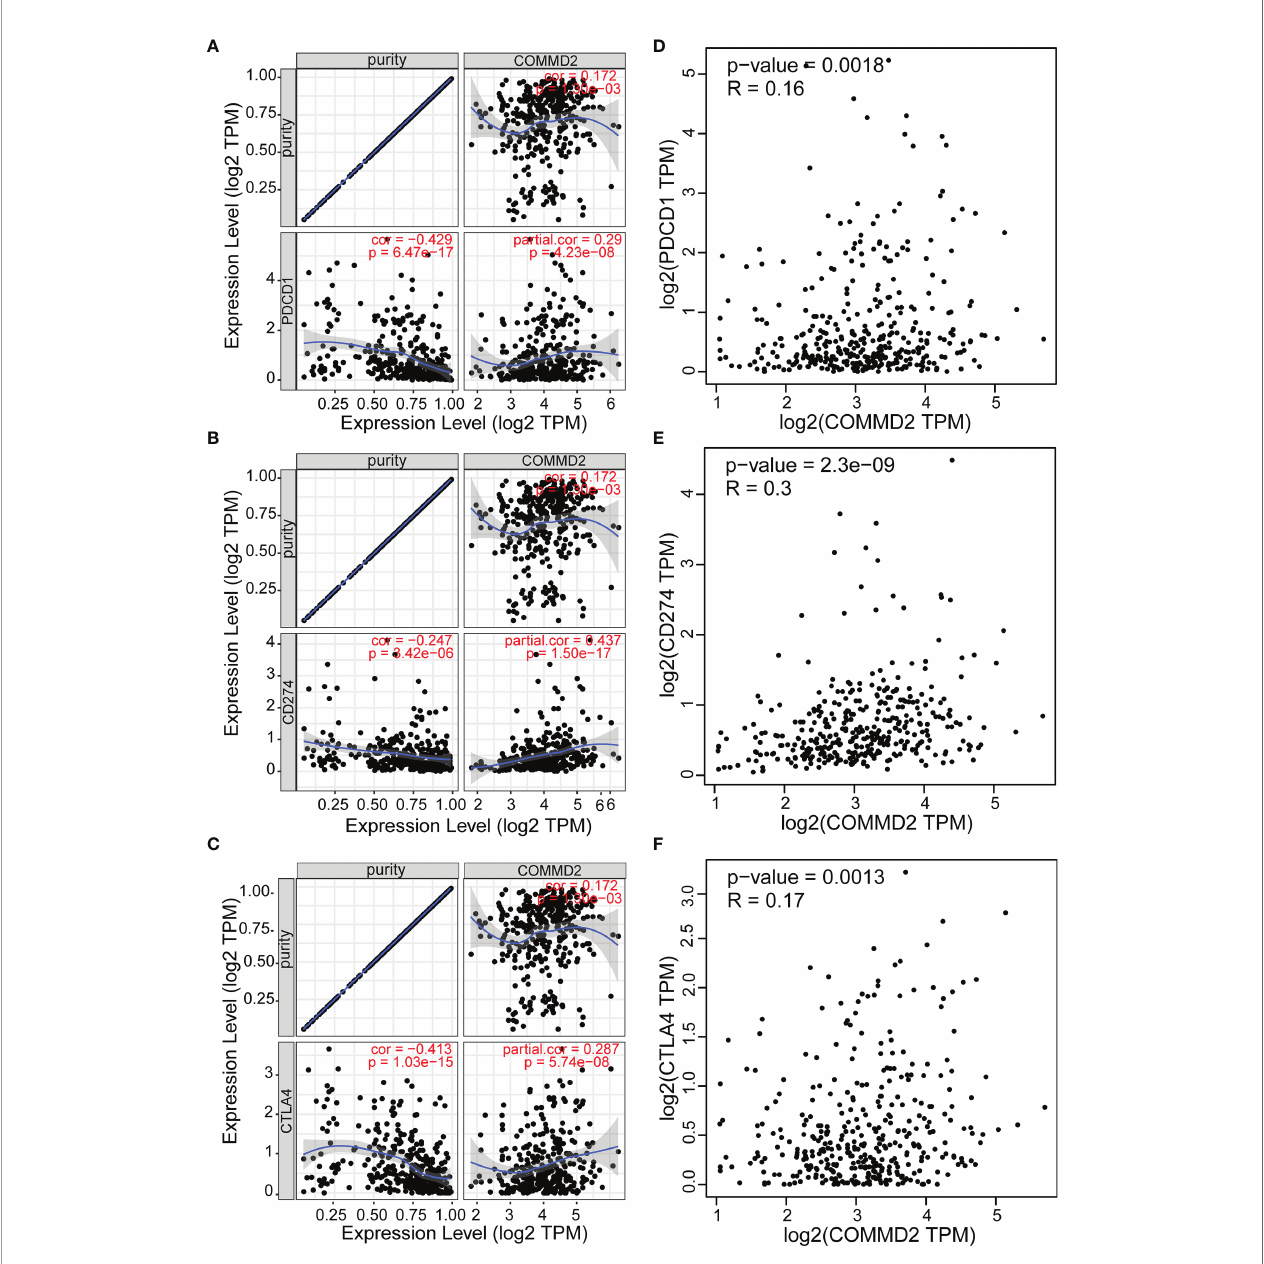
FIGURE 10 | Correlations between COMMD2 and PD-1, PD-L1 and CTLA-4 in LIHC. (A-C) Correlations of COMMD2 with PD-1 (A) , PD-L1 (B) and CTLA-4 (C) in LIHC adjusted for purity using TIMER. (D-F) Relationships of COMMD2 with PD-1 (D) , PD-L1 (E) and CTLA-4 (F) in LIHC as determined using the GEPIA